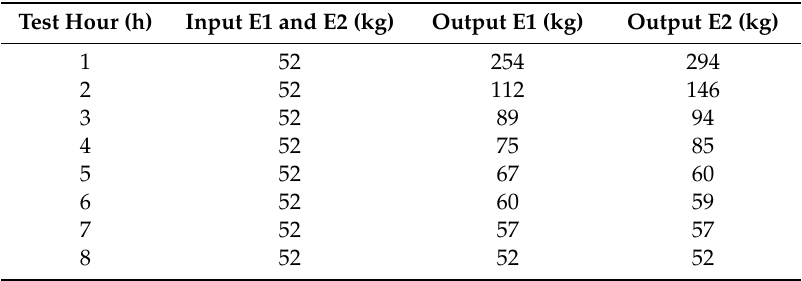
Table 3. Fed sediment load (input) vs. entrained sediment load